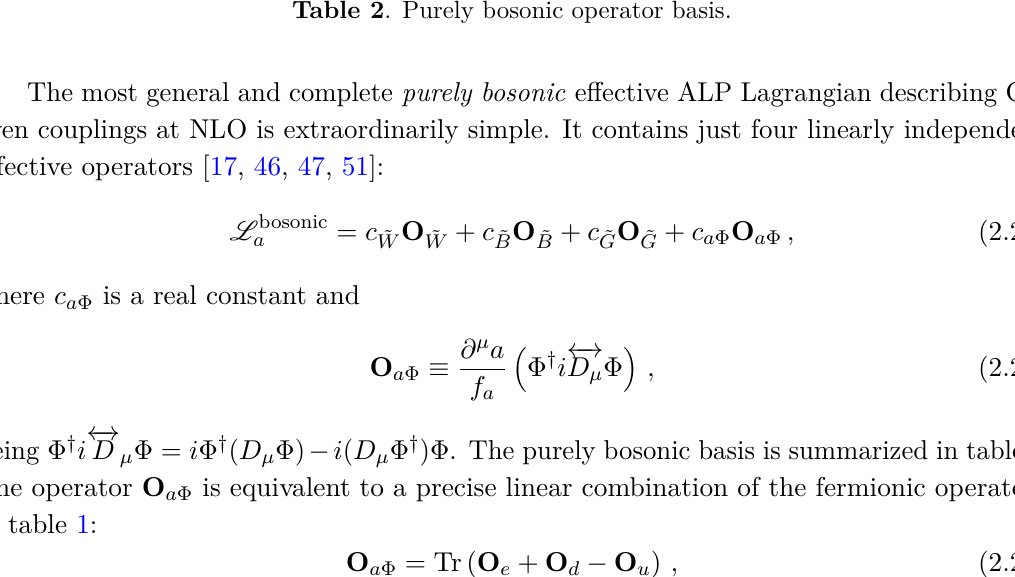
Table 2 . Purely bosonic operator